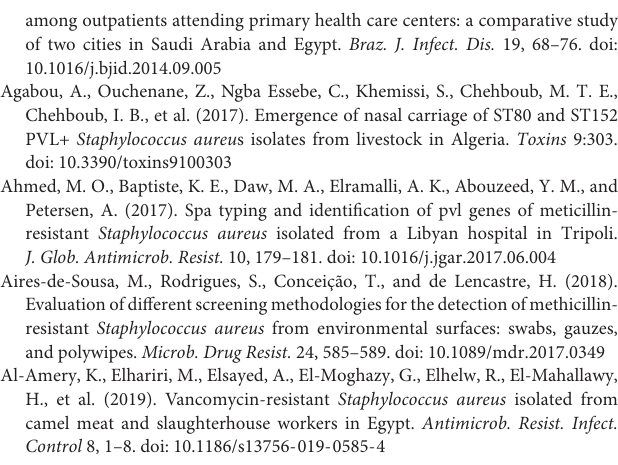
Supplementary Table 1 | Search strings used to identify eligible studies available in six electronic databases. Supplementary Table 2 | Sequence types and corresponding allele profiles used for clustering